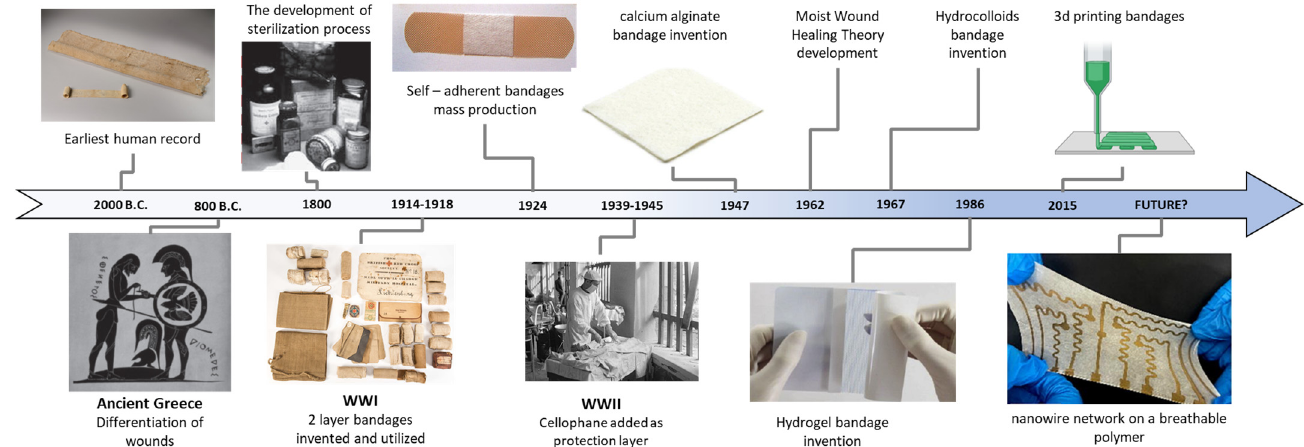
Figure 2. The development of bandages through time and major milestones throughout the last five millennia. Most of the advancements were achieved in the 20th century, particularly during the wars of the era. The adherence to skin tissue was the catalyst of using a two-layer structure [12–14], and the industrial revolution introduced mass production to the field. Earliest human record [15], ancient Greece [16], sterilization [17], WWI image [18], WWII image [19] Reproduced under the CC_BY license, Hydrogel Reprinted with permission from Heliyon, Copyright 2020, Elsevier [20], 3d printing Reprinted from “3D printing nozzle (multilayered)”, by BioRender.com (2023) Retrieved from https://app.biorender.com/biorender-templates, accessed on 9 March 2023. Future Reprinted with permission from Materials Today, Copyright 2022, Elsevier